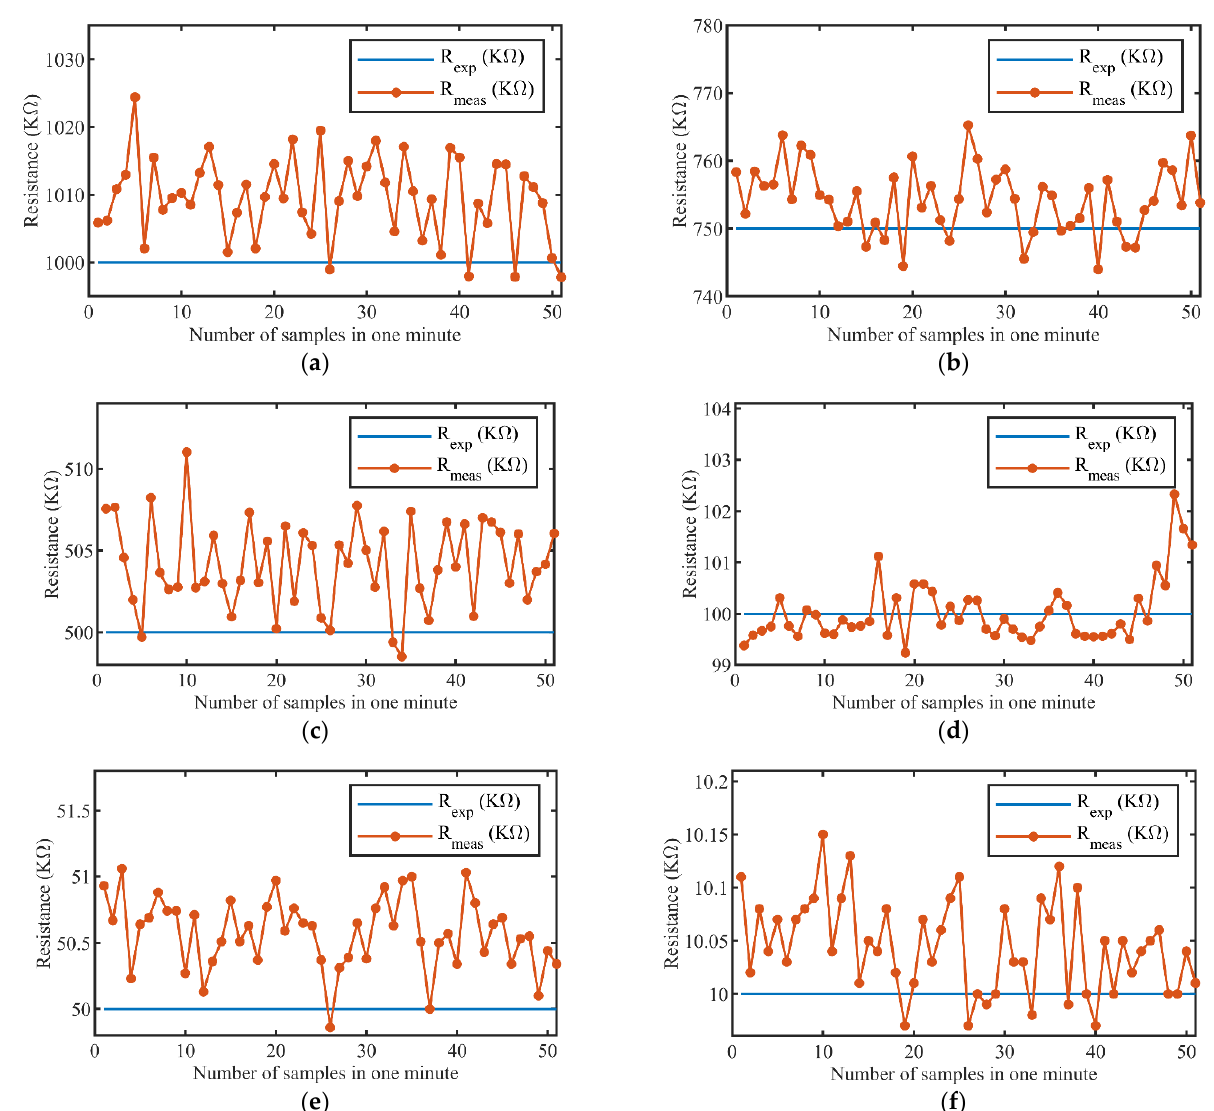
Figure 8. System response depicting the expected versus measured resistances and the average errors.